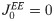
The phase diagram of the two-population rate model with threshold-linear transfer function.
J0EE=0, J0EI=0.8. The bifurcation lines predicted by the DMFT are plotted in the J0IE−J0II parameter space for K = 400 (red), 103 (blue), 104 (black), and K → ∞ (green). Red dots: Zero-crossing of the largest Lyapunov exponent (average over 5 network realizations) in numerical simulations for K = 400. Color code: Ratio of the population average firing rate of the two populations (I/E) in log scale (right). White region: The activity of the E population is very small for finite K and goes to zero in the limit K → ∞. The boundary to the right of that region is given by: J0II=J0EIIIIE=0.8.